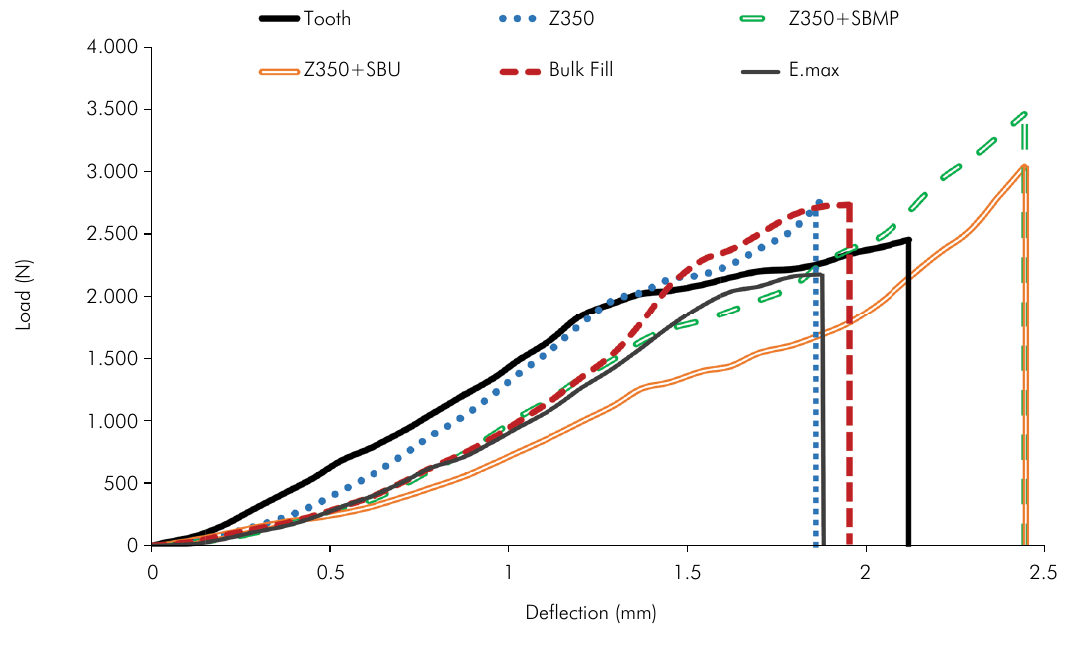
Figure 2. Load-deflection curves obtained from the average results of the endocrowns tested in this study. Z350: conventional resin composite; Z350+SBMP: conventional composite modeled with resin adhesive (SBMP); Z350+SBU: conventional composite modeled with resin adhesive (SBU); Bulk Fill: bulk fill resin composite; and E.max: IPS Empress lithium disilicate.